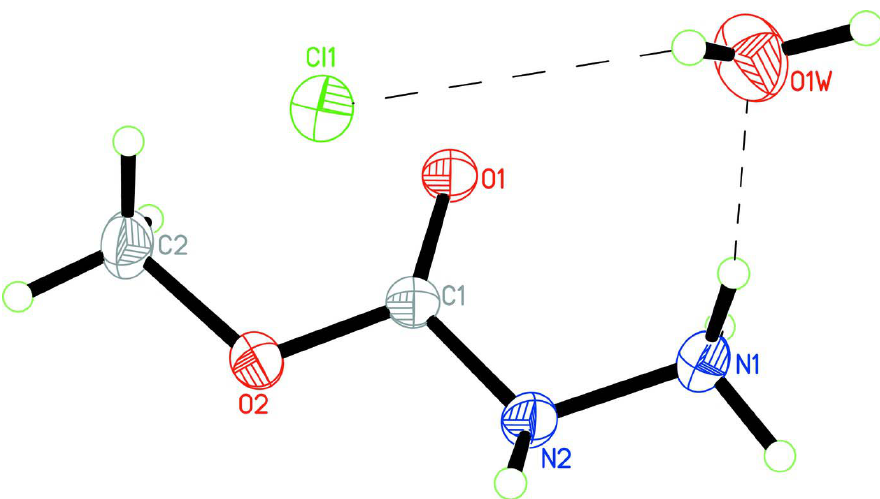
Figure 1 The molecular structure of the title compound, showing 30% probability displacement ellipsoids and the atomic numbering. Hydrogen bonds are shown as dashed lines.